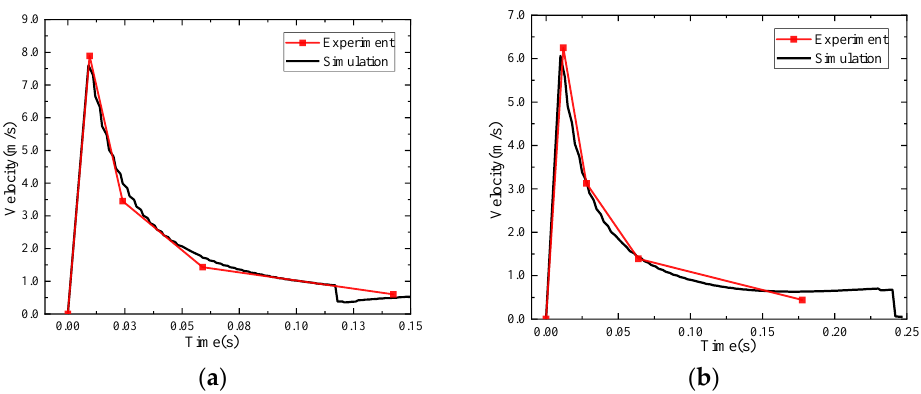
Figure 17. Time histories of particle velocity in the upstream water tank: ( a ) β = 30°, h = 205 mm; ( b ) β = 40°, h = 305 mm.